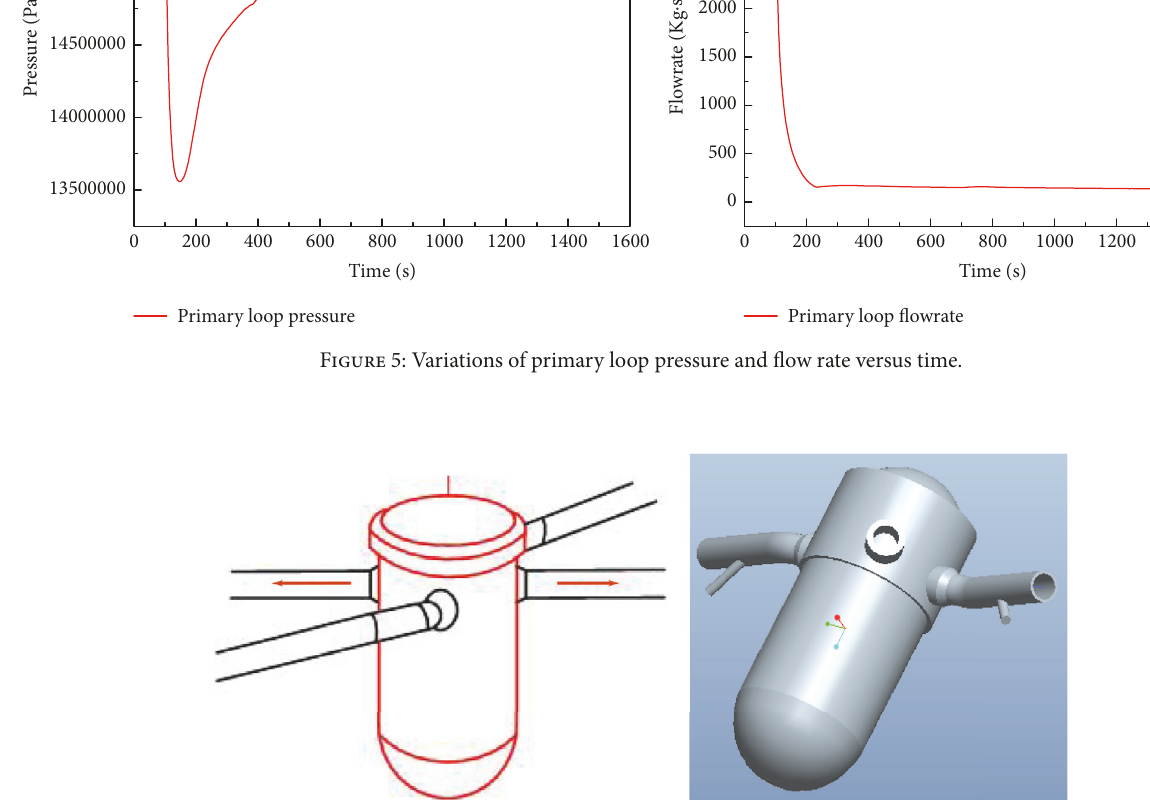
Figure 6: The whole geometry of main pipes and